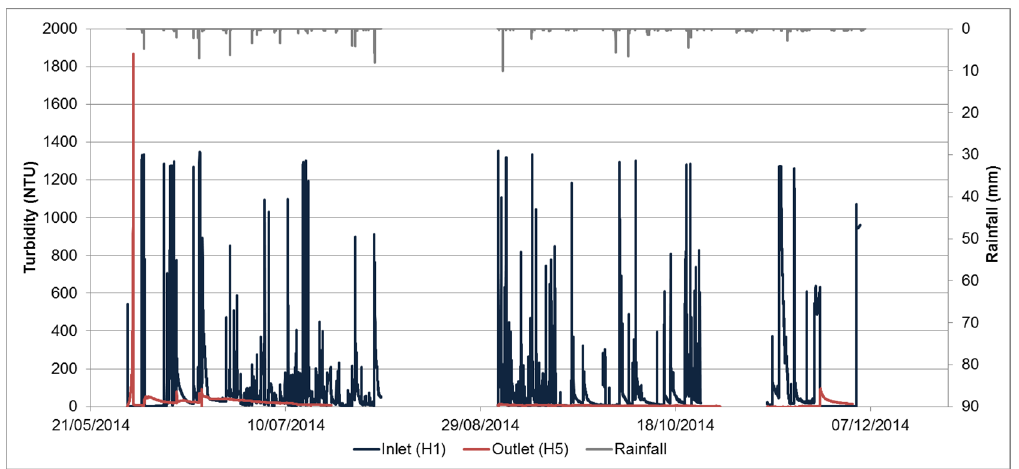
Figure 7. Turbidity of water over the monitoring period (gaps in continuous data are due to equipment malfunctions).